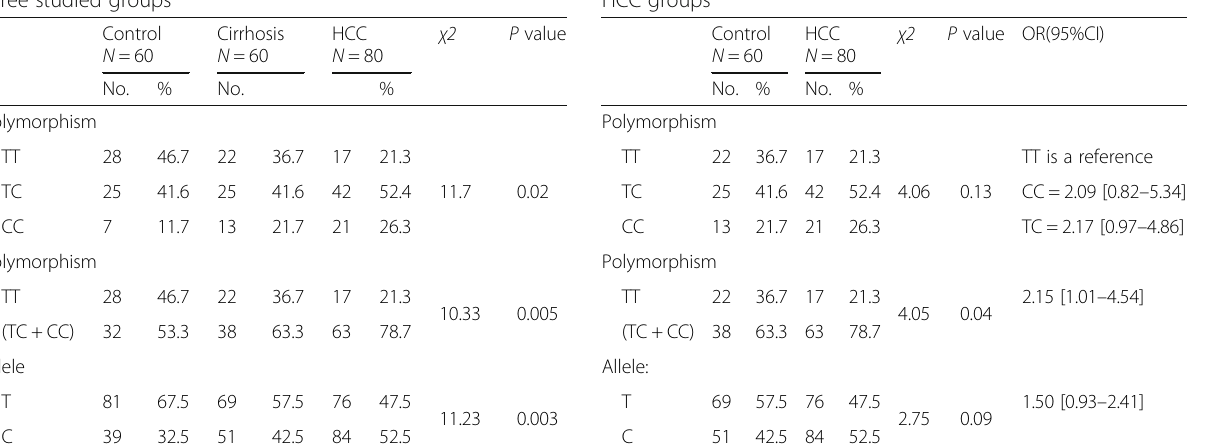
Table 5 Comparison of polymorphism between Cirrhosis